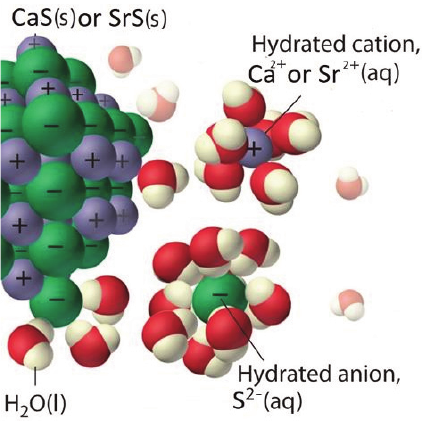
Fig. 1. Dissolution and hydration of solid SrS and CaS particles in aqueous